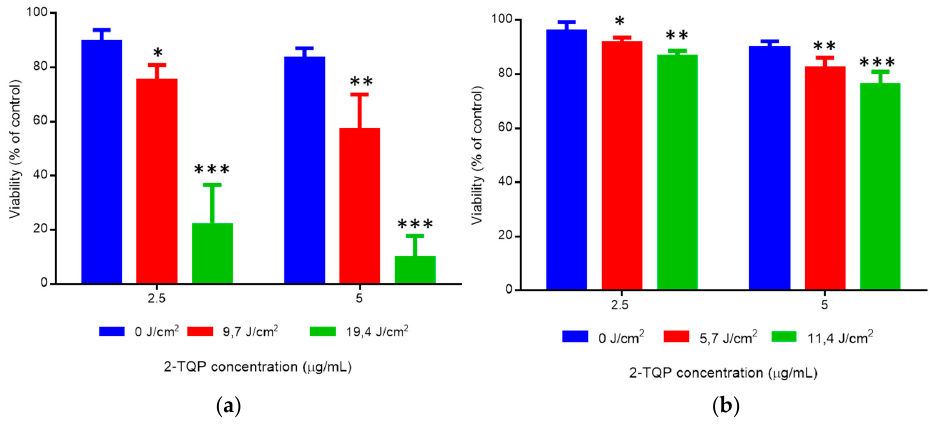
Figure 4. The photodynamic activity of 2-TQP against HT29 cell cultures was determined by the MTT assay, as described in the Experimental Section. Briefly, 24 h after 2-TQP addition, cultures were irradiated for 15 or 30 min ( a ) in the absence (fluence rate of 10.8 mW/cm 2 ) or ( b ) in the presence of an OG570 longpass filter (fluence rate of 6.3 mW/cm 2 ). For 2-TQP, 2.5 and 5.0 µ g/mL correspond to 3.1 and 6.1 µ M, respectively. The corresponding non-irradiated cultures were established and processed in parallel. Viability was determined 24 h after irradiation and expressed as a percentage of the viability of the corresponding control cultures, grown in the absence of 2-TQP. Data represent the mean ˘